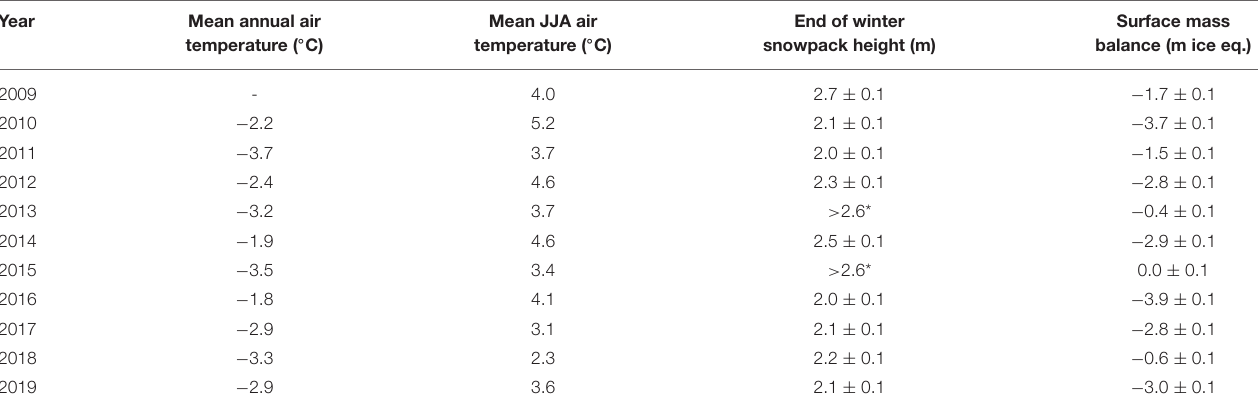
TABLE 1 | Mean annual and June, July, August (JJA) air temperatures.